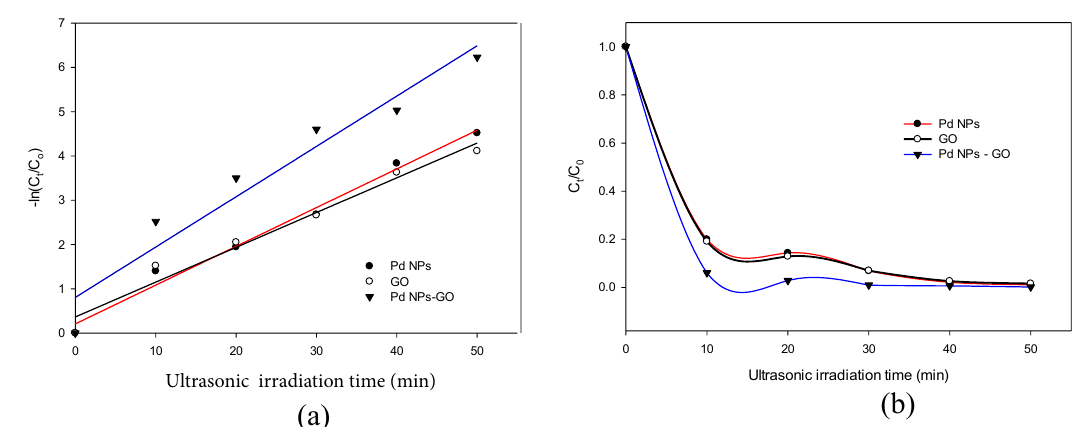
Fig. 11. The comparison of sonocatalyst degradation activity (a), Kinetic plots for the sonocatalyst degradation of IBF.